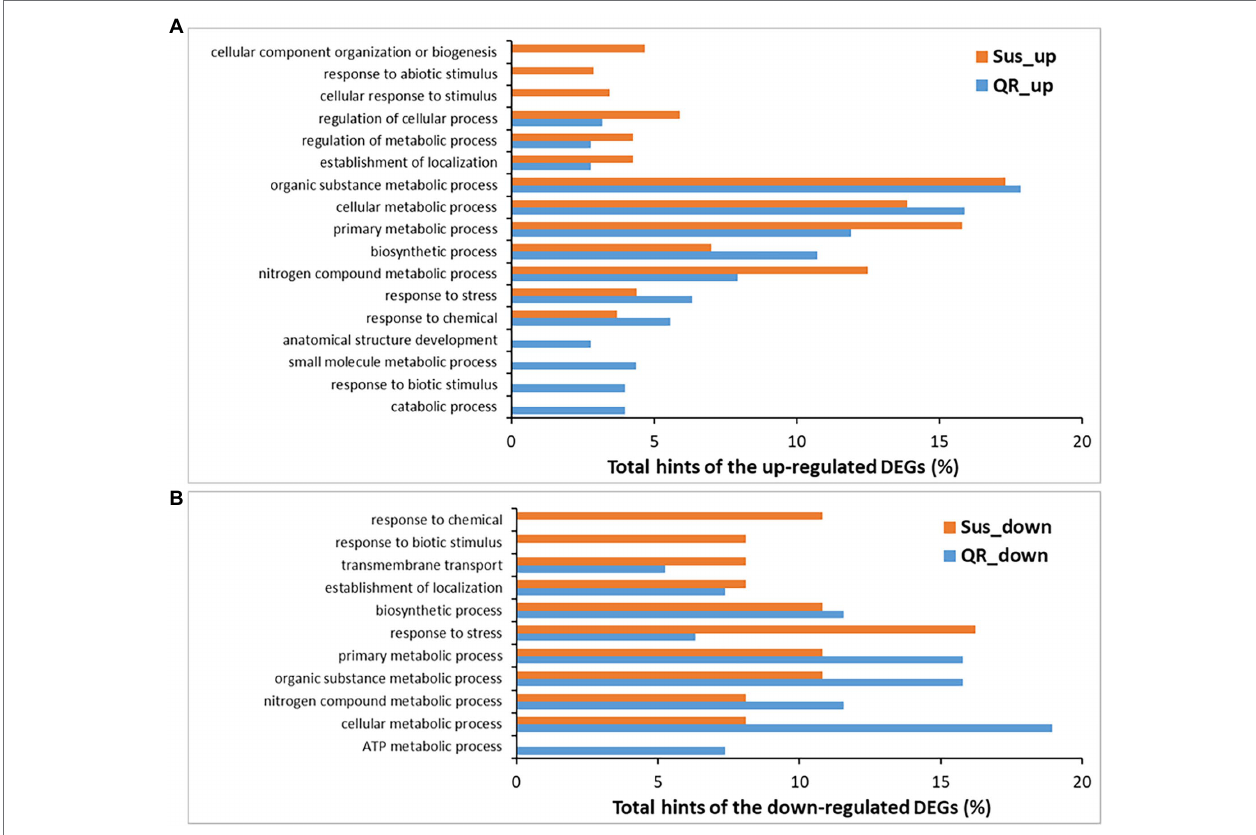
FIGURE 3 | Biological processes (level-3) annotated for differentially expressed genes (DEGs). DEGs were identified in susceptible seedlings (Sus) and seedlings with quantitative resistance (QR) post-inoculation by H. occidentale . (A) Biological processes for up-regulated DEGs, (B) Biological processes for down-regulated